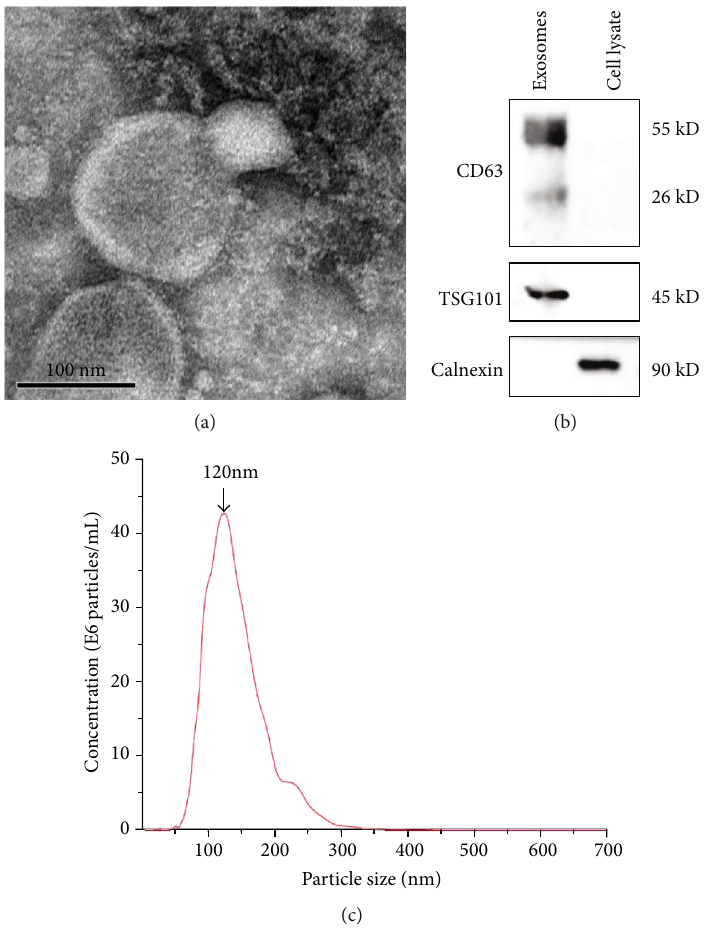
Figure 2: Characterization of exosomes derived from hPDLSCs. (a) TEM images con fi rmed the presence of exosomes, seen as cup-shaped vesicles. Scale bar: 100nm. (b) Western blot analysis of the exosome-speci fi c markers (TSG101, CD63) and endoplasmic reticulum protein (calnexin). Cell lysate of PDLSCs was used as control. (c) The particle size distribution and concentration of exosomes were measured by NTA.